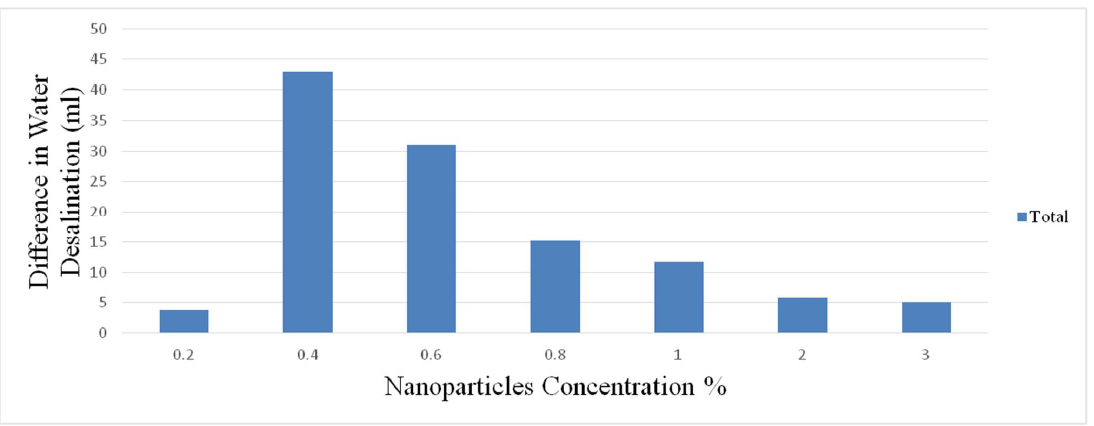
Figure 2. Effect of adding Al 2 O 3 on the condensate.